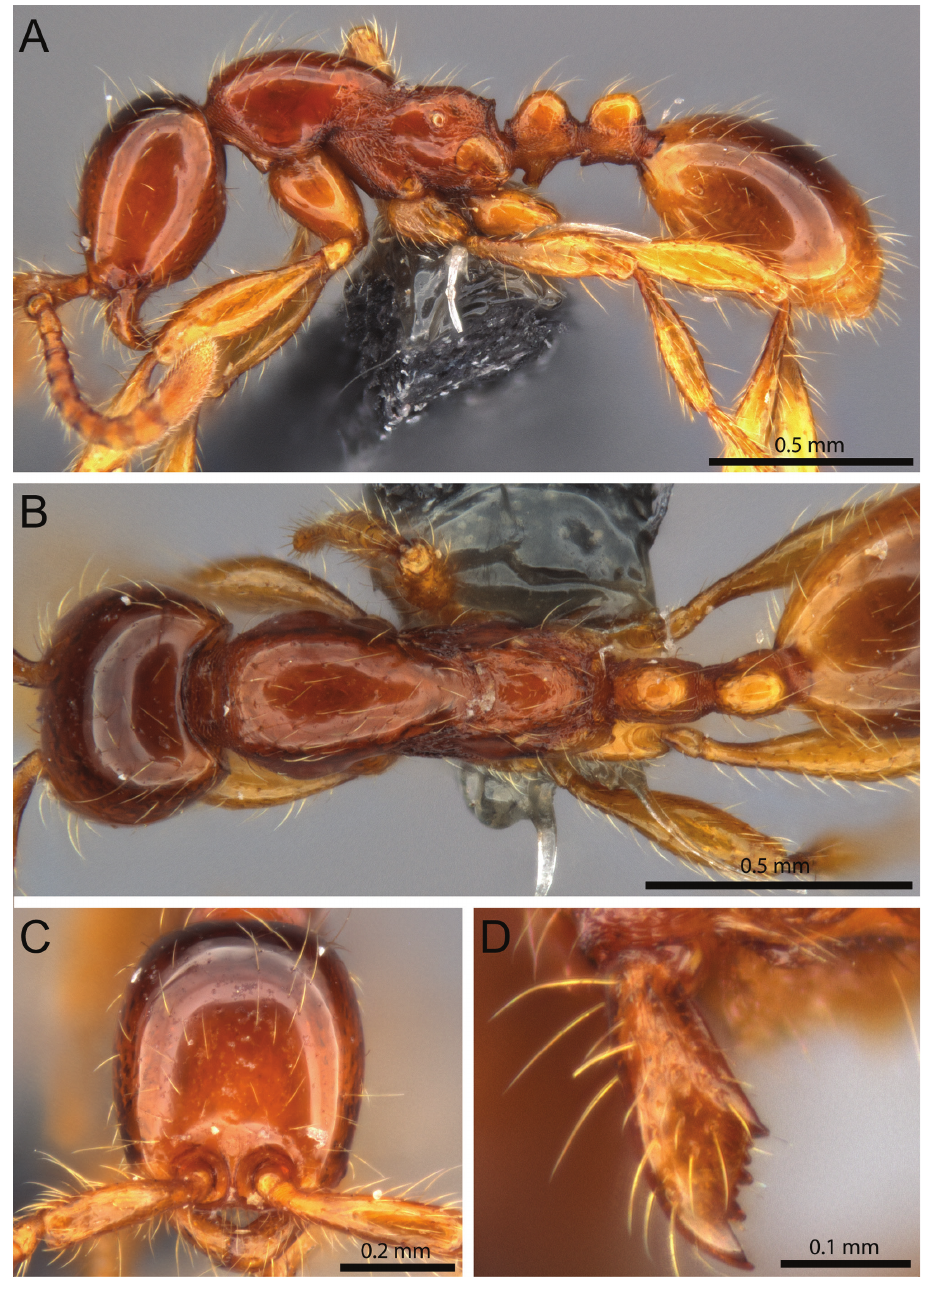
Figure 4. Aenictus yangi sp. n. (CASENT0735503). A Body in profile B Body in dorsal view C head in full-face view D right mandible in frontal